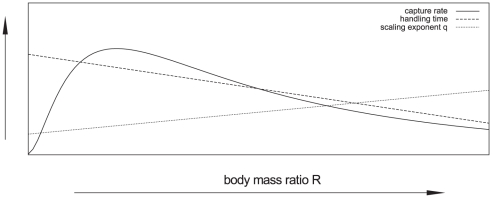
Conceptual graphic showing allometric relationships in the single-prey functional response parameters capture rate, handling time and the scaling exponent q as revealed by the previous study of Vucic-Pestic and colleagues [18].